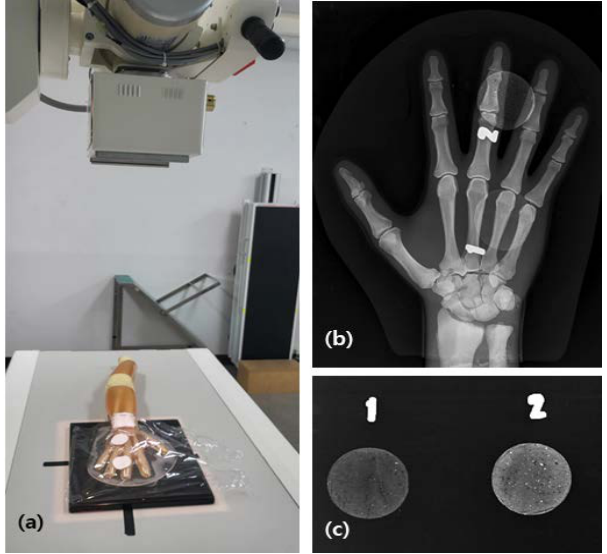
Figure 8. Degree of dispersion of the protective cream according to the speed (rpm) and temperature of the mixer observed with an optical microscope (×40); ( a ) 1000 rpm, ( b ) 2000 rpm, ( c ) 3000 rpm, ( d ) 50 °C, ( e ) 70 °C .